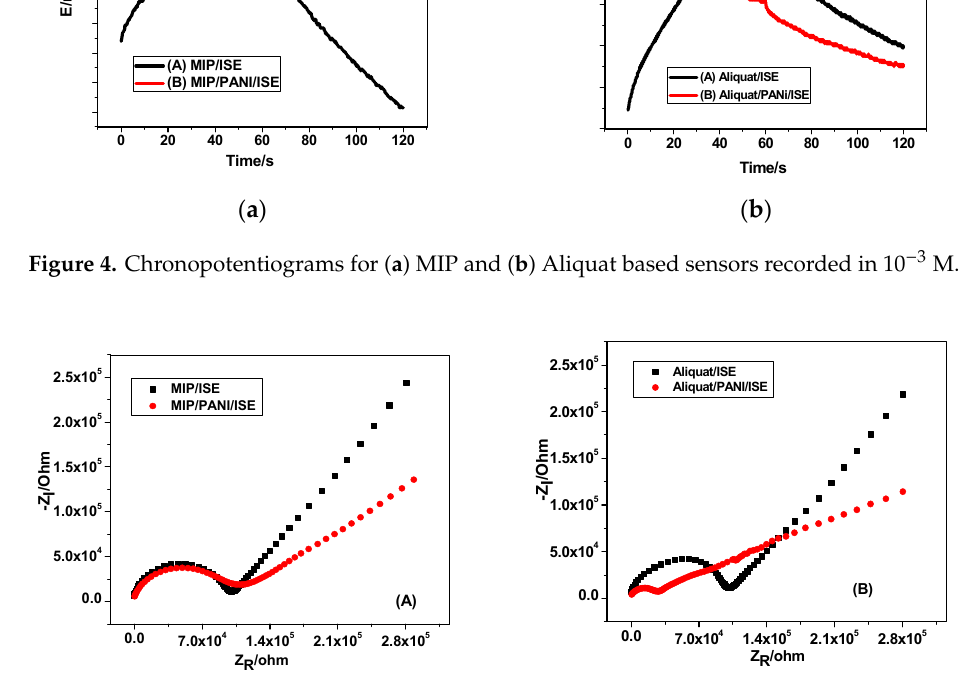
Figure 6. Water layer tests for flucarbazone ISEs based on ( A ) MIP; and ( B ) Aliquat.